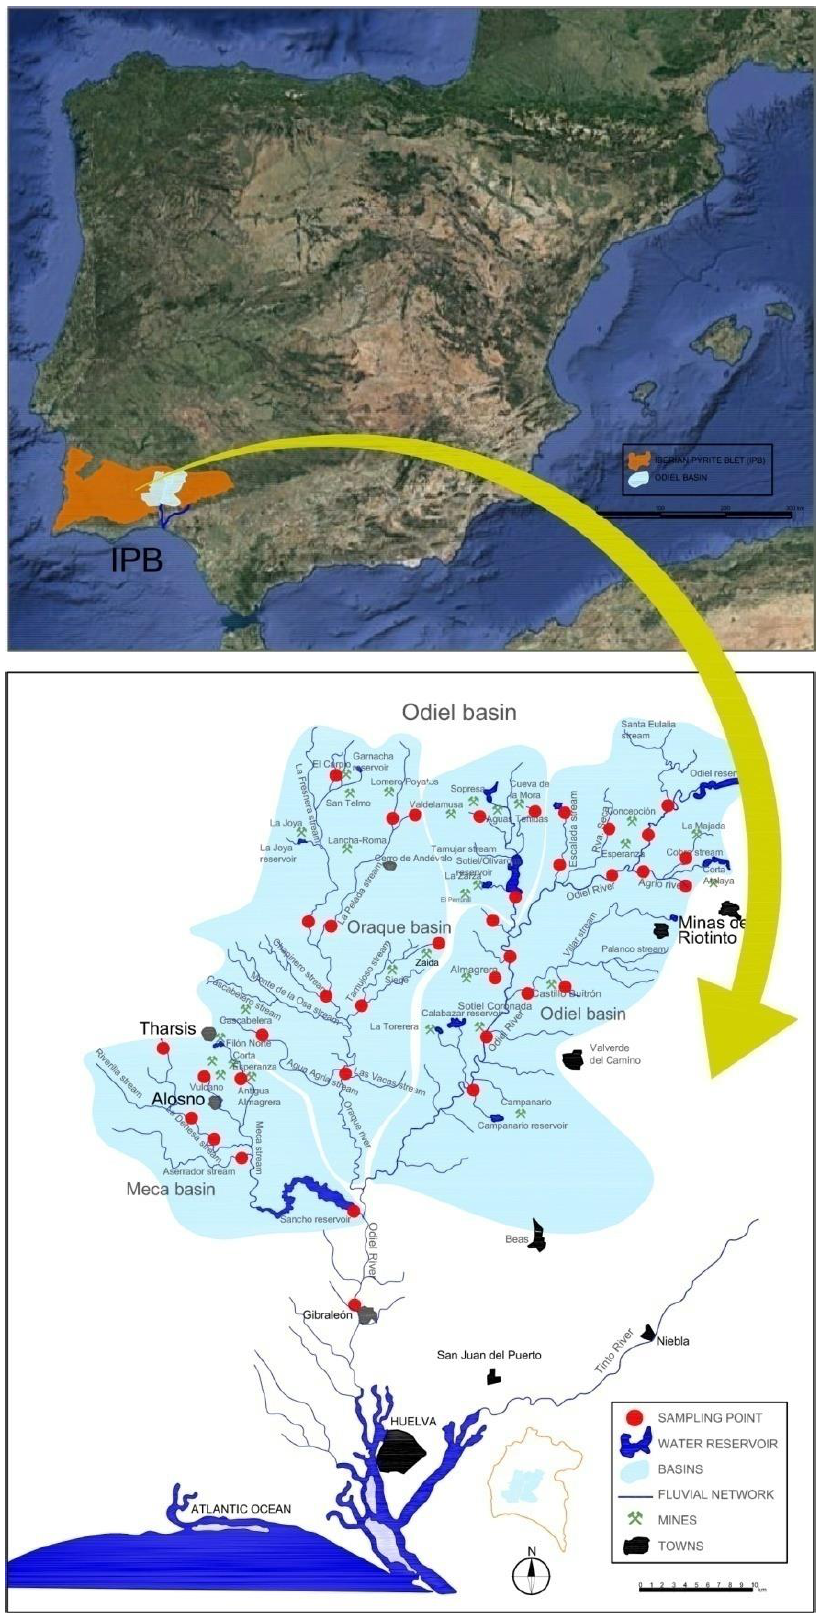
Figure 1. Location setting. It can be seen the Iberian Pyrite Belt ( up ) and the Odiel Basin ( down ).